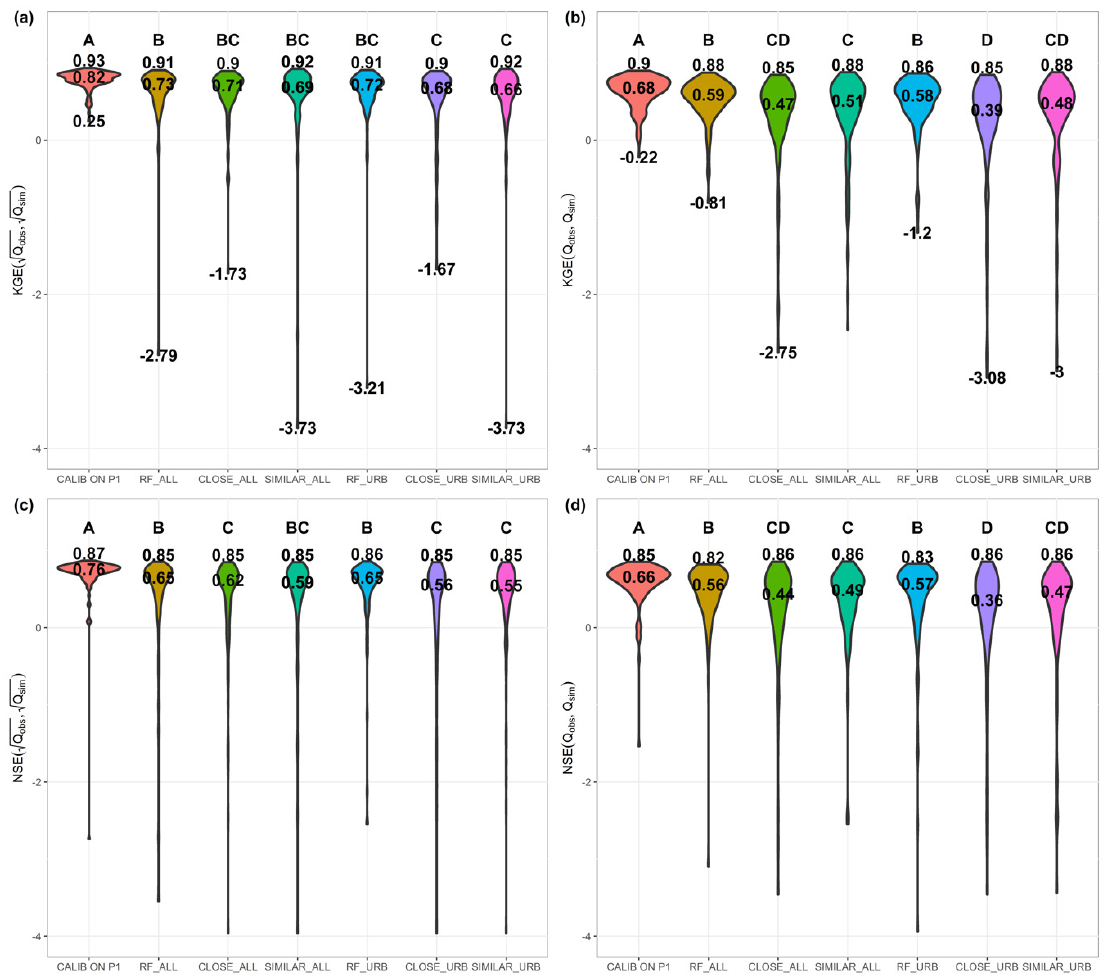
ffi ciency (KGE) ( c ) NSESR